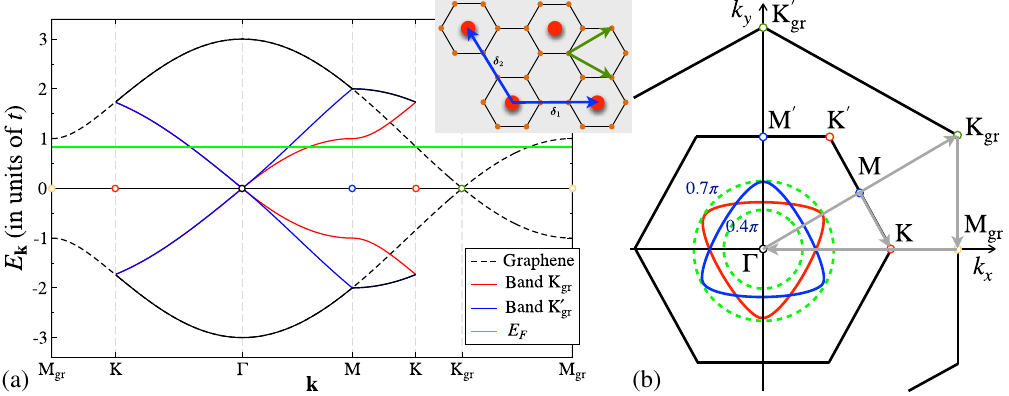
FIG. 2. (a) Energy bands of graphene in its full BZ (dashed lines) and folded onto Eu-lattice BZ to represent the rigid-band structure of Γ M ð K Þ K Eu-intercalated graphite (solid lines) along the paths M M shown in diagram (b); high-symmetry points are highlighted. gr gr gr Two Dirac bands are color-coded to indicate their origin before folding. Energies are in units of the graphene tight-binding hopping 0 . 83 t ≈ 2 . 62 eV. It matches the Fermi momenta k ≈ parameter t ¼ 3 . 16 eV [4]. The horizontal line is the Fermi energy E F ¼ F; min ≈ 0 . 7 π =a from Ref. [31] of the trigonally warped Fermi surfaces shown in diagram (b) that approximately 0 . 48 π =a and k F; min correspond to the 0 . 5 e filling of the bands. Inset: crystal structure of Eu-GIC from Fig. 1 with primitive translational vectors of Eu and C lattices. (b) Brillouin zones of the graphene and of the Eu-based triangular lattice. Fermi surfaces at E are color-coded according to the F 0 . 4 π =a and 0 . 7 π =a (dashed lines). High- bands in diagram (a). Two representative circular Fermi surfaces are shown, with k F ¼ symmetry paths are indicated by the